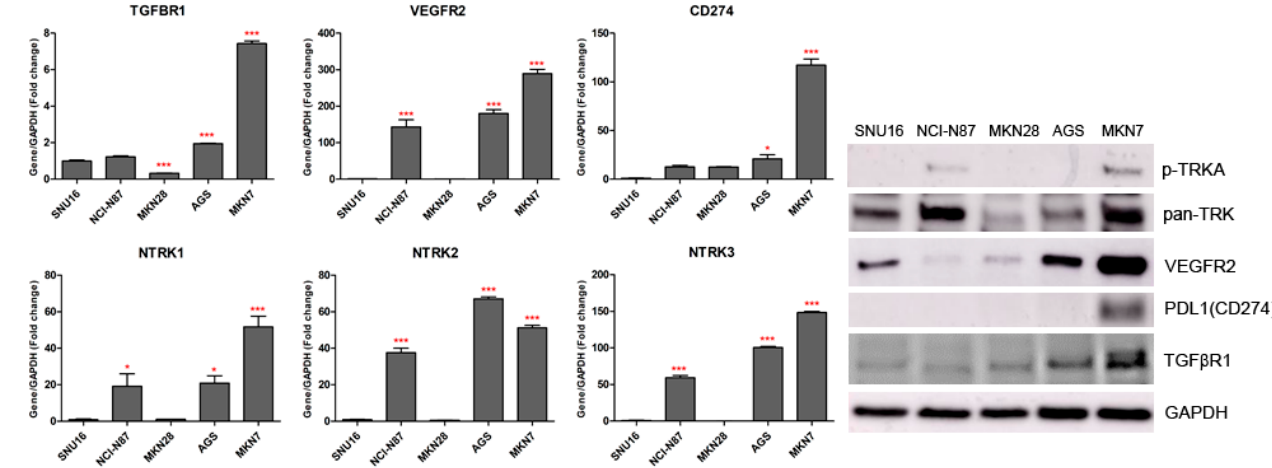
Figure 2. TGFBR1, VEGFR2, CD274, and NTRK1/2/3 gene and protein expression levels measured by quantitative real-time PCR and western blotting in gastric cancer cell lines. * p < 0.05 and *** p < 0.001 compared with SNU16 cell line.